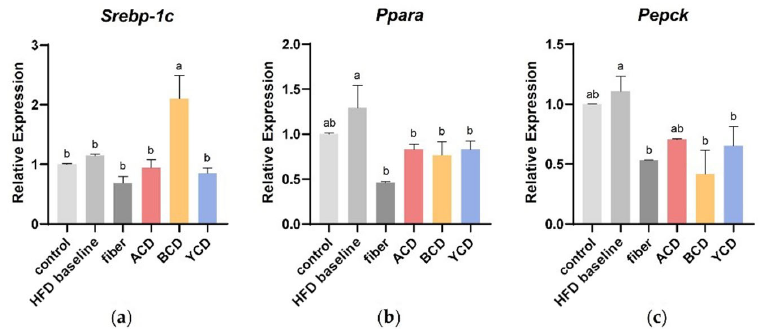
Figure 7. α -CD, β -CD, and γ -CD supplementation altered the expression of lipid metabolism-related Figure 7. α‐ CD, β‐ CD, and γ‐ CD supplementation altered the expression of lipid metabolism ‐ re ‐ lated genes. The relative expression of ( a ) Srebp ‐ 1c (sterol ‐ regulatory element binding protein ‐ 1c); genes. The relative expression of ( a ) Srebp-1c (sterol-regulatory element binding protein-1c); ( b ) Ppar α ( b ) Ppar α (peroxisome proliferator activated receptor ‐α ); and ( c ) Pepck (phosphoenolpyruvate car ‐ (peroxisome proliferator activated receptor- α ); and ( c ) Pepck (phosphoenolpyruvate carboxykinase) in boxykinase) in liver tissue . n = 6. Control, low ‐ fat diet; HFD baseline, high ‐ fat diet without cellulose; liver tissue. n = 6. Control, low-fat diet; HFD baseline, high-fat diet without cellulose; fiber, high-fat diet; ACD, high-fat diet that replaced α -CD with cellulose; BCD, high-fat diet that replaced β -CD with cellulose; YCD, high-fat diet that replaced γ -CD with cellulose. Data are expressed as means ± SEM. Values not sharing a common superscript differ significantly among groups ( p < 0.05, ANOVA).